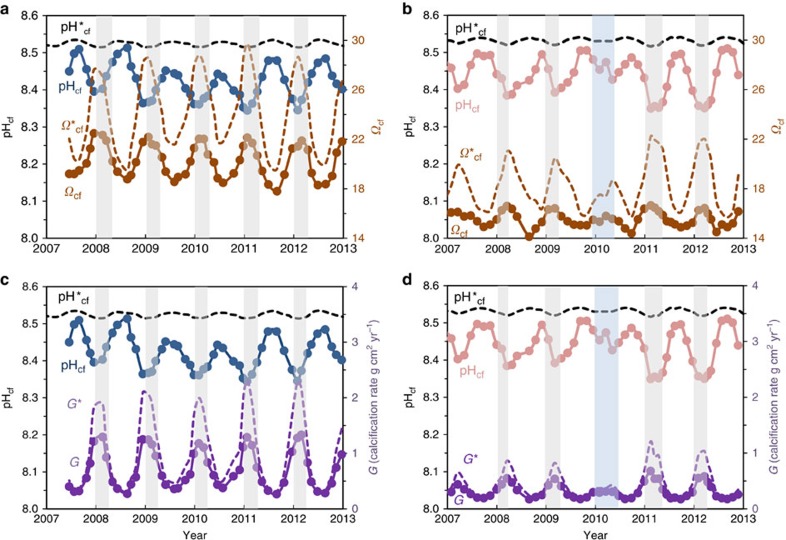
Seasonal time series of calcifying fluid pHcf and Ωcf together with calculated calcification rates G.(a) Calcifying fluid pHcf and Ωcf values for Porites coral (D-2) from Davies Reef (GBR), where Ωcf=[Ca2+]cf [CO32−]cf/Karag. Dashed line shows the Ω*cf calculated using fixed experimental1017 pH*cf values (see Fig. 2a,b). (b) Same as previous for Coral Bay (Ningaloo Reef, Western Australia) Porites (CB-2). (c) Calcification rates calculated using the inorganic rate equation28
G=k(Ω−1)n, where k and n are the temperature-dependent constant and order of the reaction, respectively28. Because of opposing changes in pHcf relative to DICcf (Fig. 1), Ωcf and hence coral growth rates are strongly modulated reducing seasonal variations by twofold compared to those estimated from fixed condition experiments (G*). (d) Same as previous for Porites from Coral Bay (Ningaloo Reef, Western Australia).